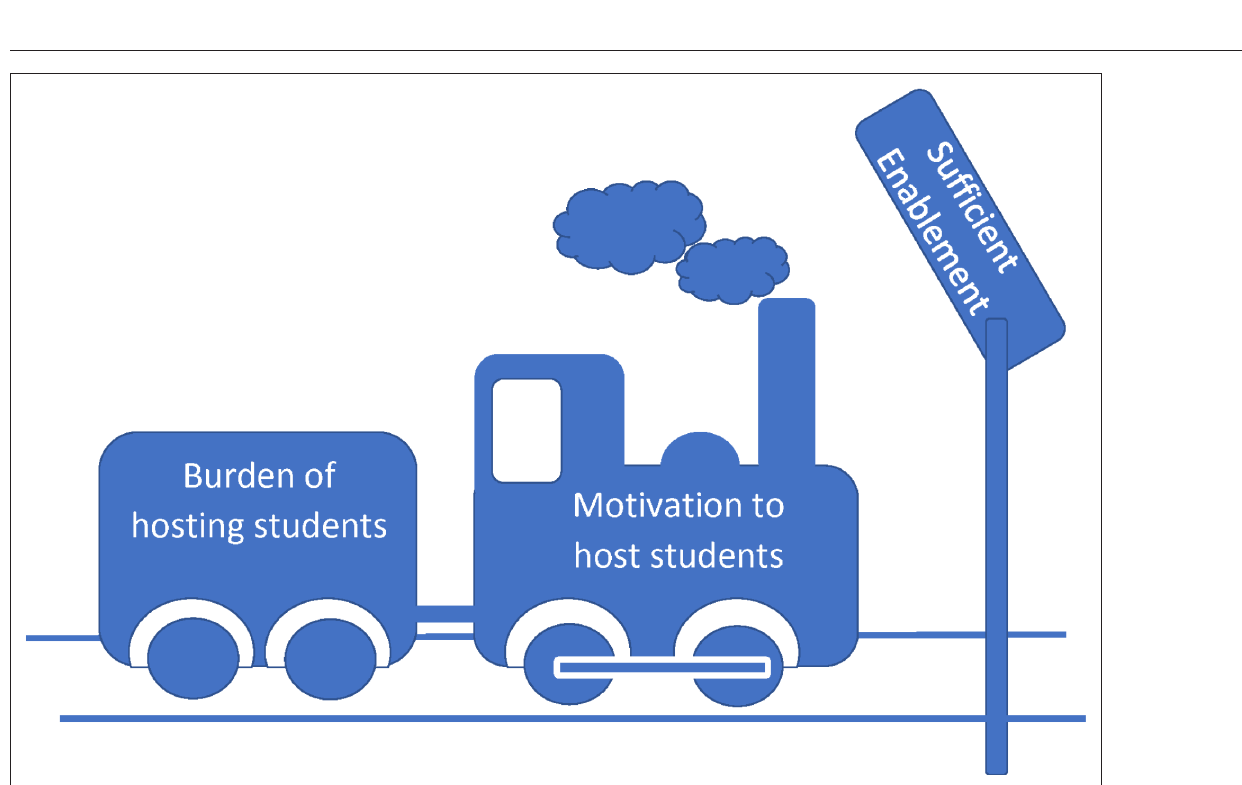
Figure 2 Factors influencing a practice decision to continue hosting medical student